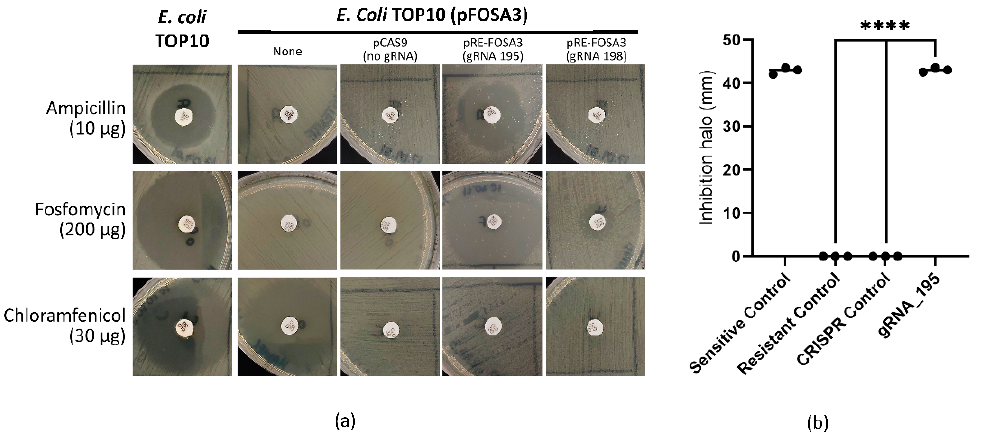
Figure 3. Disk diffusion test with E. coli grown on Mueller–Hinton agar. ( a ) Representative pho- tographs of disk diffusion plates obtained in one of the assays showing the presence/absence of inhibition halos. ( b ) A graph showing the data obtained from the inhibition halos, with fosfomycin disks ( µ g) supplemented with glucose-6-phosphate; data were obtained in biological and technical replicates; black dots represent individual measurements of the inhibition halos, and asterisks in- dicates significant difference **** p < 0.0001. Sensitive control: TOP10/pFOSA3 – ; CRISPR control: TOP10/pFOSA3 + /pCAS9 + ; Resistant control: TOP10/pFOSA3 + ; gRNA_195: TOP10/pFOSA3 + /pRE- FOSA3 gRNA_195 . The inference was made with an unpaired t -test with Welch correction. Growth curves for bacteria in the presence or absence of fosfomycin were analyzed to determine the sensitivity to fosfomycin. While the resistant control (pFOSA3 + ) and